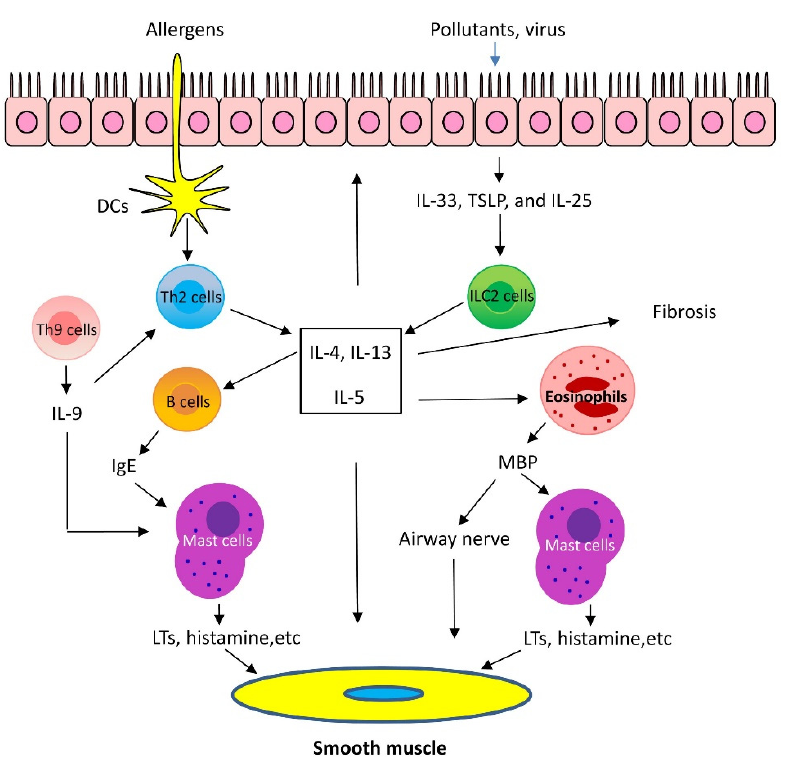
Figure 1. Mechanism of Th2-high asthma. When allergens enter the low airways, dendritic cells (DCs) present the allergens to Th2 cells, which secrete Th2 cytokines, including interleukin (IL)-5, IL-4, and IL-13. IL-4 and IL-13 activate B cells, which produce IgE. IgE subsequently binds to surface of mast cells. When the same allergens enter the airways, they interact with IgE, which induces mast cells to release mediators, such as leukotrienes (LTs), histamine, and ILs. These mediators irritate airway smooth muscle and induce bronchoconstriction. In addition, IL-5 facilitates eosinophil recruitment to the lungs. Eosinophils also release mediators, including major basic protein (MBP), which stimulates mast cells to release histamines and LTs. MBP also inhibits M 2 receptor and promotes acetylcholine release from cholinergic nerves and induces bronchospasm. Furthermore, IL-13 directly sensitizes airway smooth muscle contraction, stimulates epithelial cells to secret mucins, and induces fibrosis. Th9 cells can secrete IL-9, which activates Th2 cells and promotes mast cell accumulation. Lastly, epithelium injury by infection and pollutants induces release of cytokines, including thymic stromal lymphopoietin (TSLP), IL-25, and IL-33, which activate type 2 innate lymphoid cells (ILC2) and produce Th2 cytokines, such as IL-5 and IL-13.